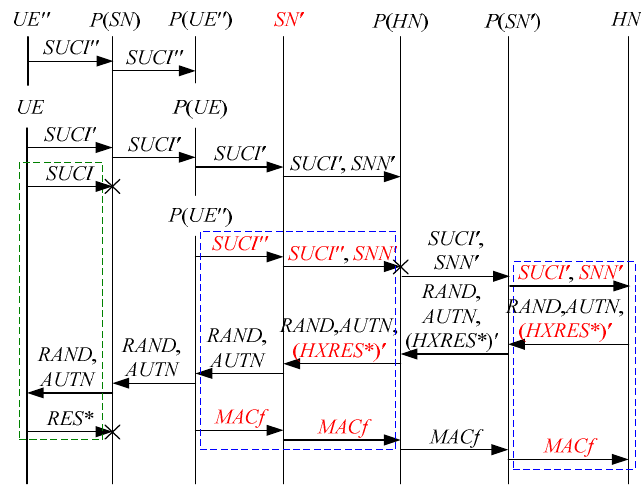
Figure 5. The fourth attack scenario of the 5G AKA protocol.